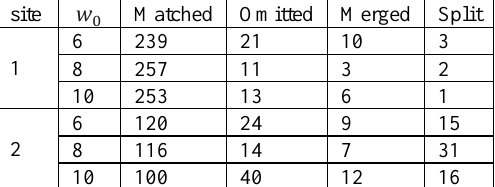
Table 3: The accuracy statistics of the delineation tree crowns using U-Net for test sites 1 and 2. 𝜎 was set as 5.